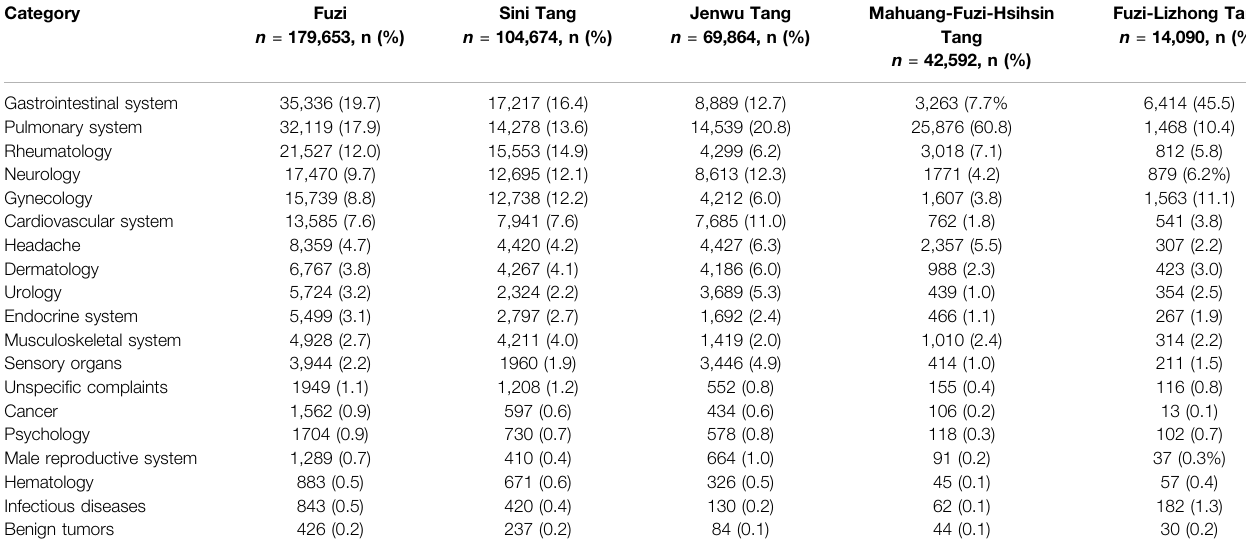
Corresponding ICD-9-CM codes of each category were listed in Supplementary Table S2 . The sensory system includes ophthalmology and otolaryngology.